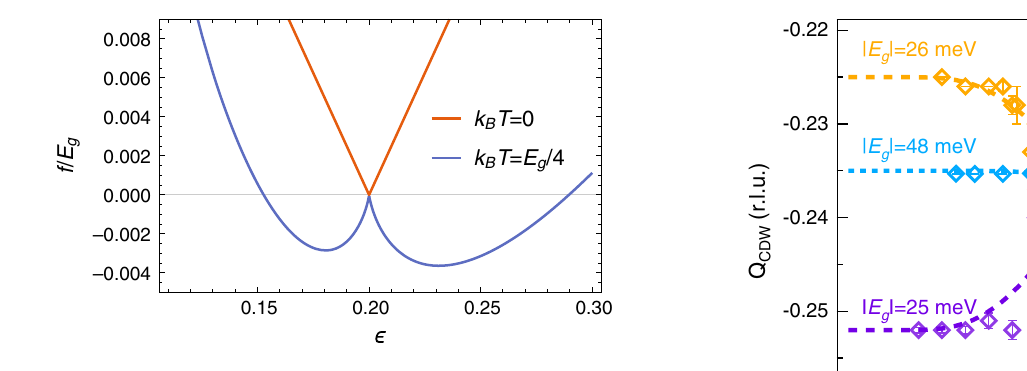
FIG. 5. Free energy per Cu as a function of the incommensu- rability. Here, we show the free energy of the entropy model at x ¼ 0 . 1 for two different temperatures (in units of the gap due to hole ordering along the charge stripe). At zero temperature the solution with ϵ ¼ 2 x is favored, while at a finite temperature two values of ϵ minimize the energy, with the one having ϵ > 2 x prevailing.